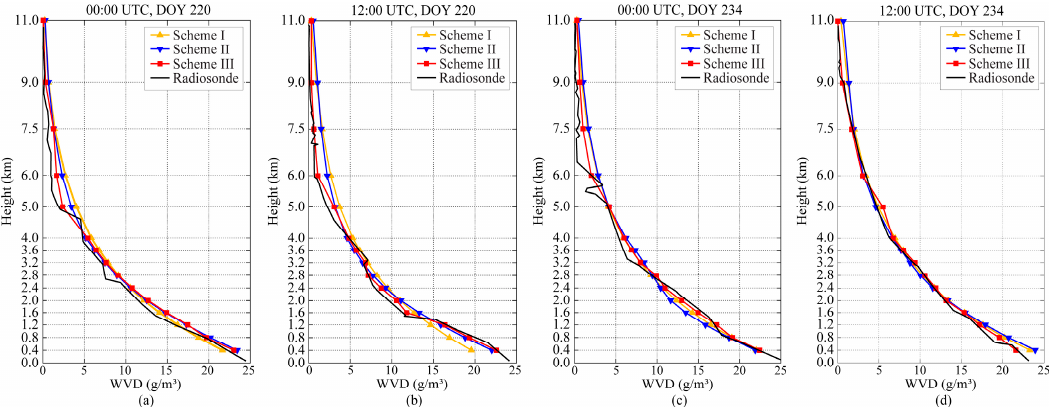
Figure 15. Comparison of the tomographic water vapor profiles for three schemes under different weather conditions using the radiosonde data (black lines) as a reference. ( a ) 00:00 UTC, DOY 220; ( b ) 12:00 UTC, DOY 220; ( c ) 00:00 UTC, DOY 234; and ( d ) 12:00 UTC, DOY 234.